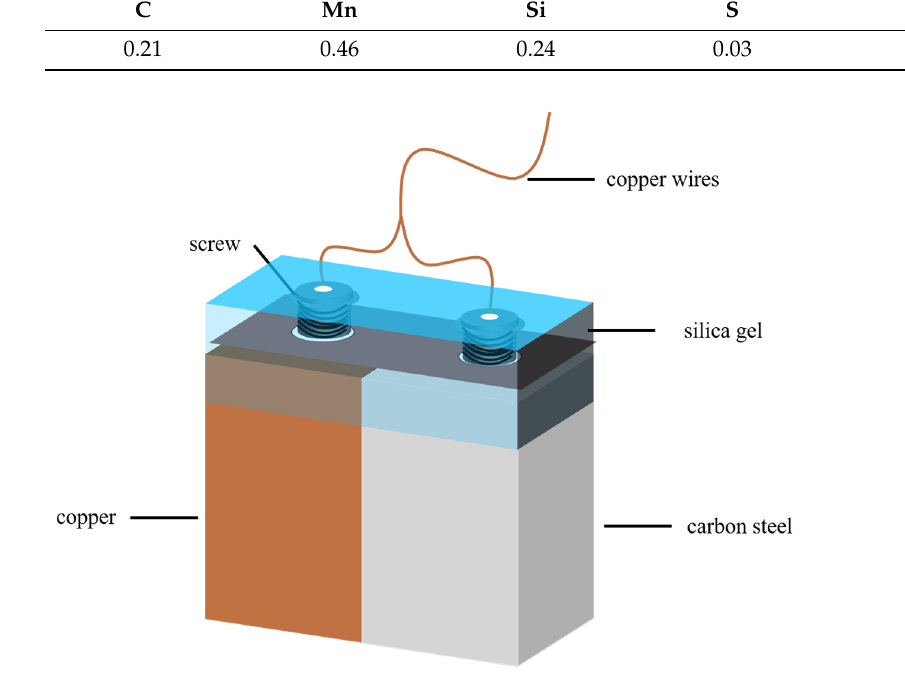
Figure 1. Schematic illustration of steel–copper coupled electrode used for weight loss test.